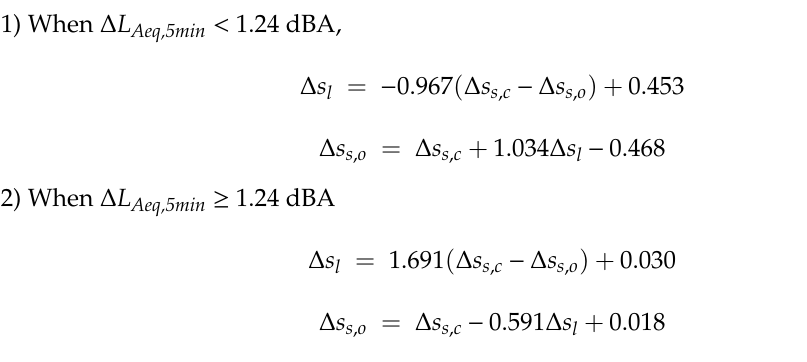
Figure 7. The relationship between Δ s l and the gap between Δ s s,c and Δ s s,o .